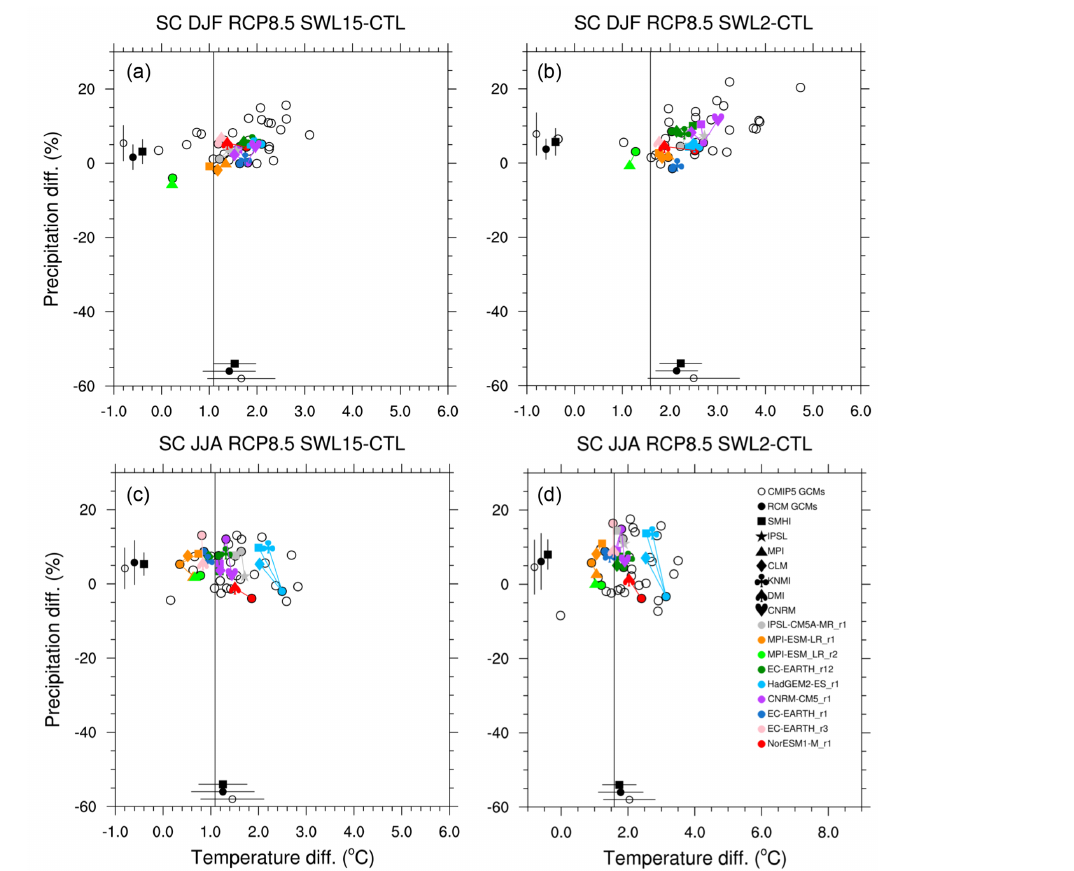
Figure 8. Temperature and precipitation changes over Scandinavia (SC, Fig. 1) for winter (a, b) and summer (c, d) mean conditions. Panels (a, c) show SWL1.5 and (b, d) SWL2. The error bars plotted inside the axis in the diagram illustrate the average and plus or minus 1 SD from (i) the CMIP5 ensemble (Table 2), (ii) the nine-member GCM ensemble that has been downscaled and (iii) the 18-member RCM ensemble (Table 1). Unfilled circles are CMIP5 GCMs listed in Table 2 that have not been downscaled. Filled circles represent GCMs that have been downscaled and these are connected by a line to the RCM(s) that have been used for downscaling. The vertical line represents the global mean warming at SWL1.5 and SWL2 relative to the control period